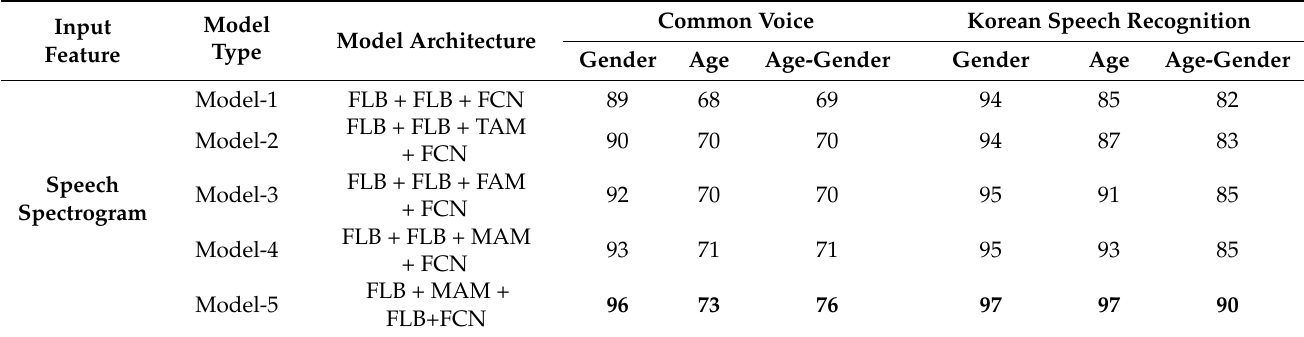
Table 5. Classification accuracy (%) of the five different CNN models on the development set. All models were trained and evaluated for gender, age, and age-gender classification using the Common Voice and Korean speech recognition datasets. Numbers with bold fonts indicate the highest classification